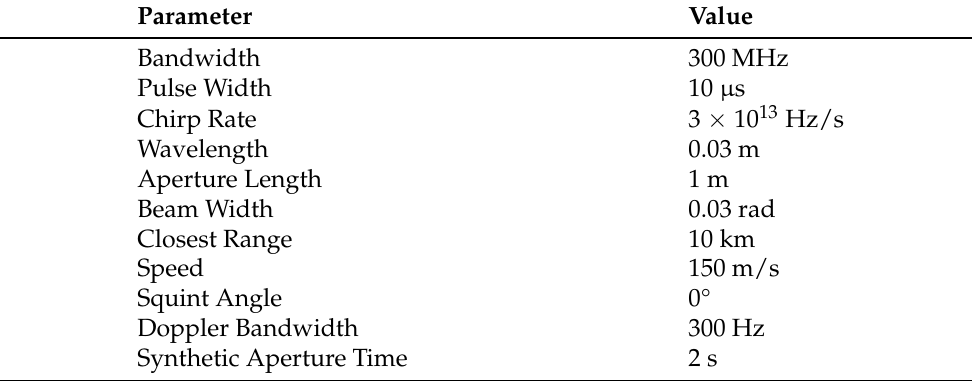
Table 1. SAR parameters.